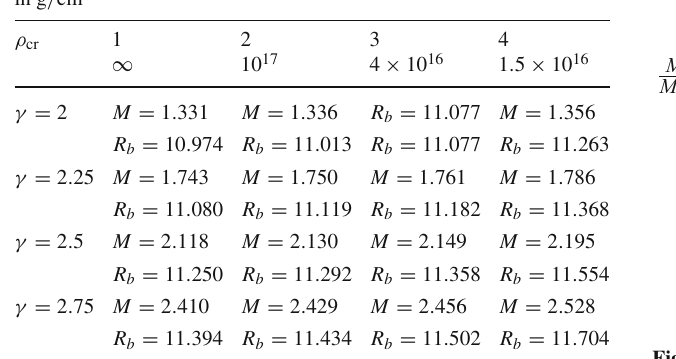
Fig. 3 Mass–radius relation for compact objects with ECT-inspired corrections and polytropic equation of state with k = 7 . 454 × 10 − 3 and γ = 2 . 5. The solid curve (1) shows the purely relativistic case. The dashed curve (2) is obtained for ρ cr = 8 × 10 17 g / cm 3 , the dotted curve (3) is obtained for ρ cr = 4 × 10 17 g / cm 3 , the dash-dotted curve (4) is obtained for ρ cr = 2 × 10 17 g / cm 3 . See Table 2 for